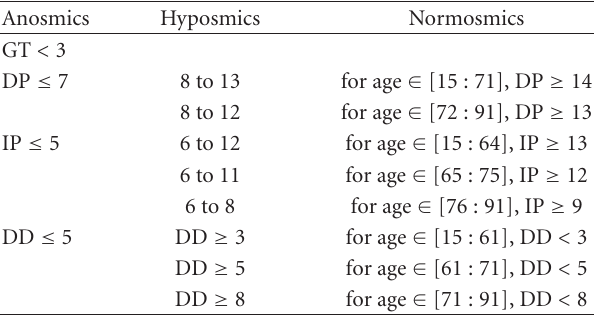
Table 5: Decision table for GT, DP, IP, and DD.